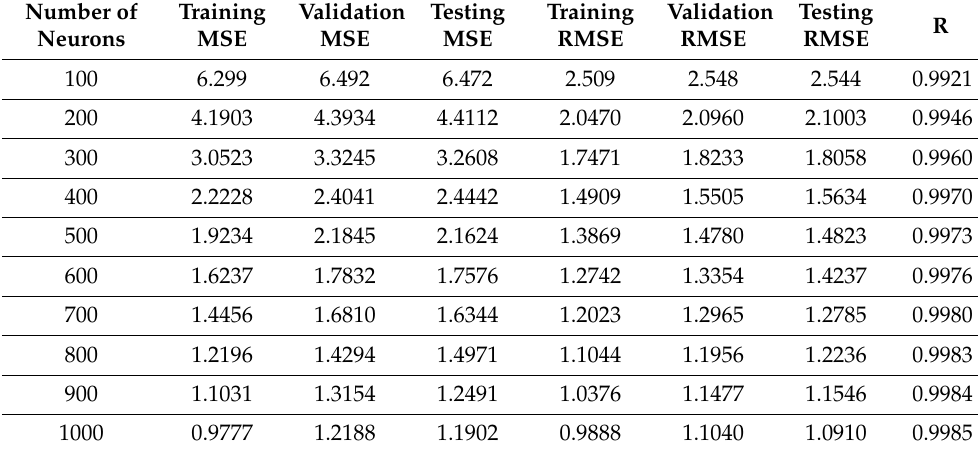
Table 2. MSE, RMSE, and R values when training the NFS model using the LM